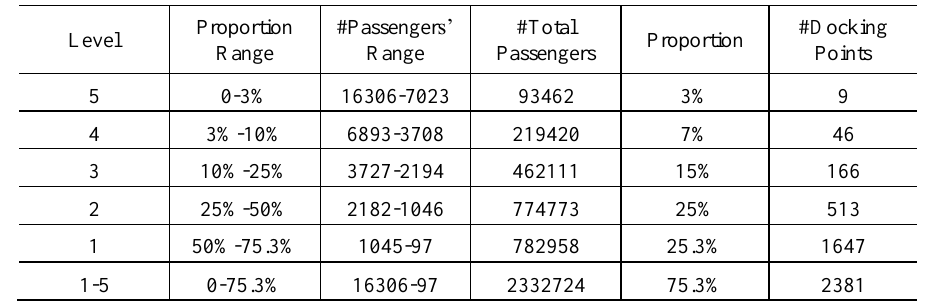
Table 1. Extraction results of pick-up docking points